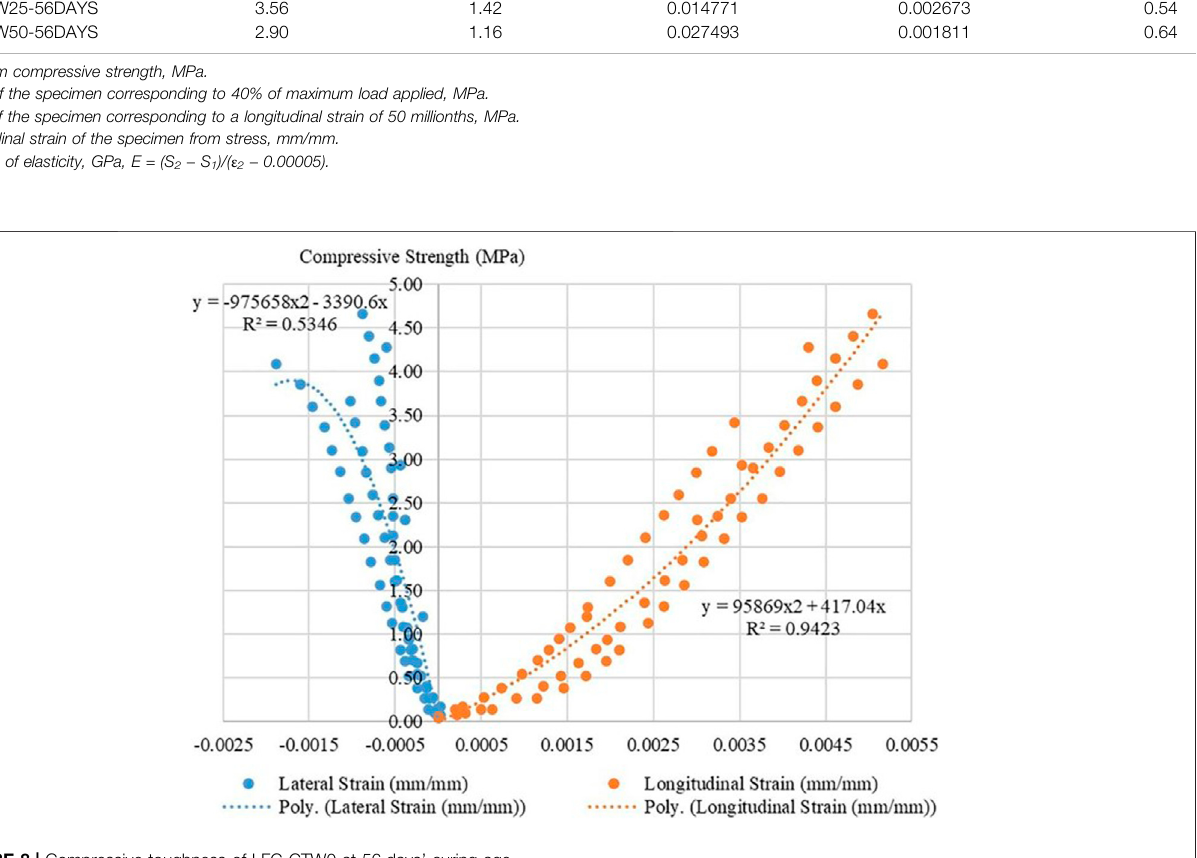
Frontiers in Built Environment |